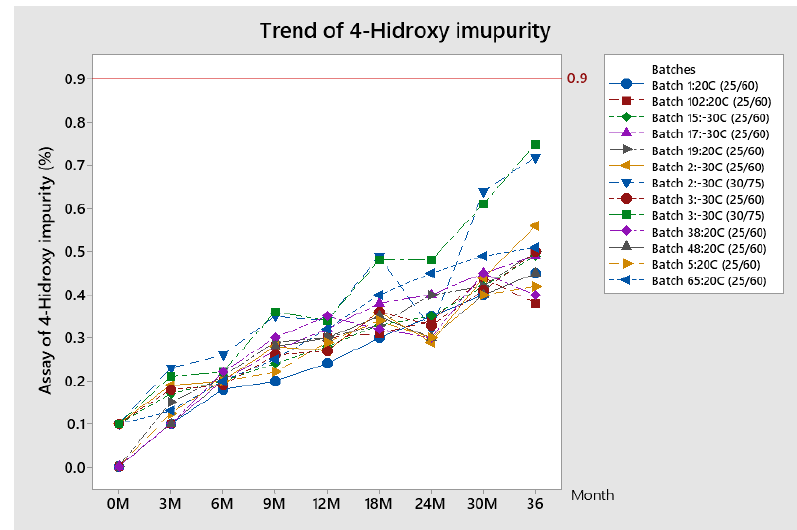
Figure 8. Trend of 4-hydroxy impurity for stability batches. The assay of 4-hydroxy impurity shows a constantly increasing trend during the stability study at both conditions. There is no difference between results at different conditions. By the end of the shelf life for all batches, the assay of this impurity is around 0.5%, far enough from the prescribed specification limit of 0.9%.